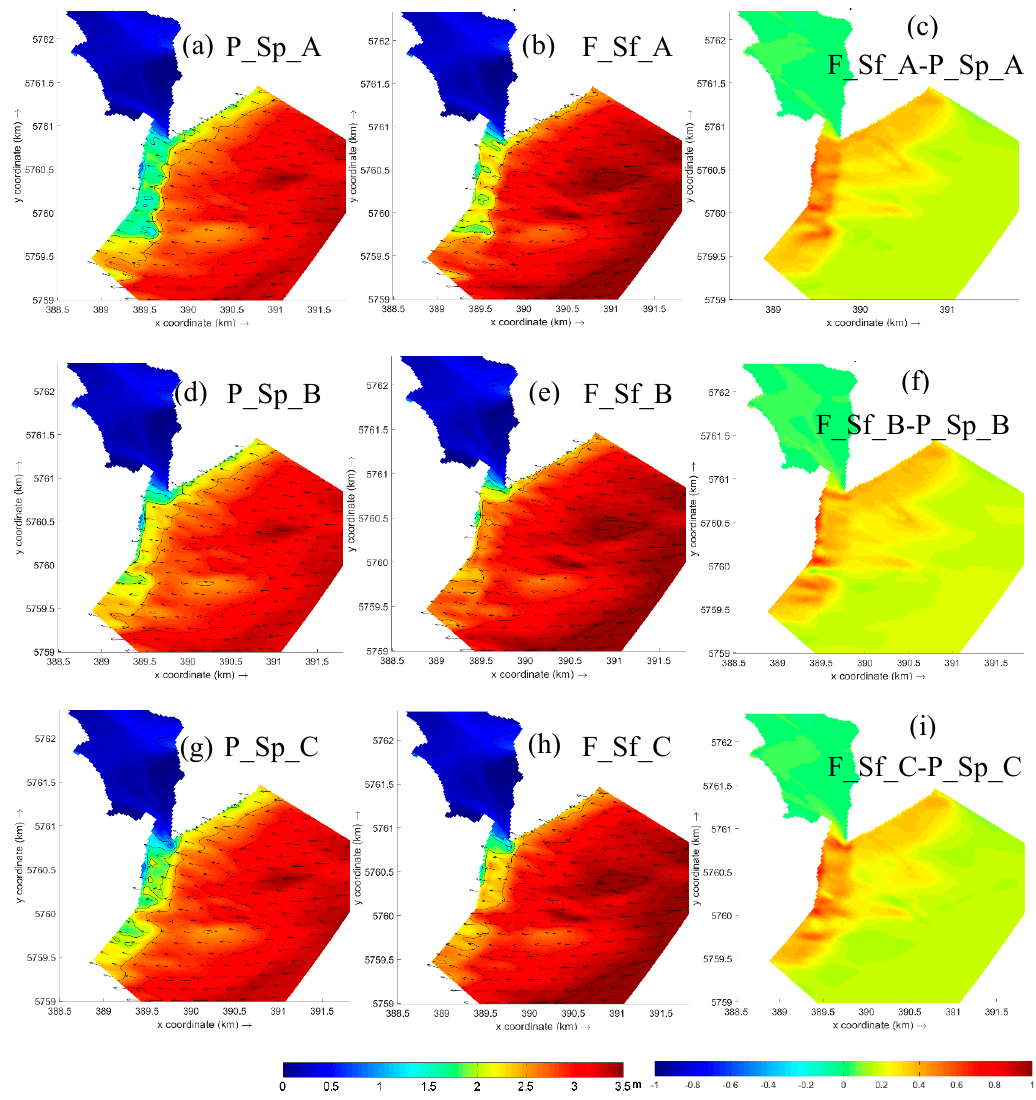
Figure 12. Storm wave height distributions at and around Deben Estuary under different scenarios (Table 3) in: State A (top), State B (middle), and State C (bottom). ( a ) Storm wave height distribution under P_Sp_A scenario; ( b ) Storm wave height distribution under F_Sf_A scenario; ( c ) difference between F_Sf_A and P_Sp_A (Future minus present); ( d ) Storm wave height distribution under P_Sp_B scenario; ( e ) Storm wave height distribution under F_Sf_B scenario; ( f ) difference between F_Sf_B and P_Sp_B (Future minus present); ( g ) Storm wave height distribution under P_Sp_C scenario; ( h ) Storm wave height distribution under F_Sf_C scenario; ( i ) difference between P_Sf_C and P_Sp_C (Future minus present). The arrows indicate the mean wave directions. All the named scenarios are referred to Table 3.